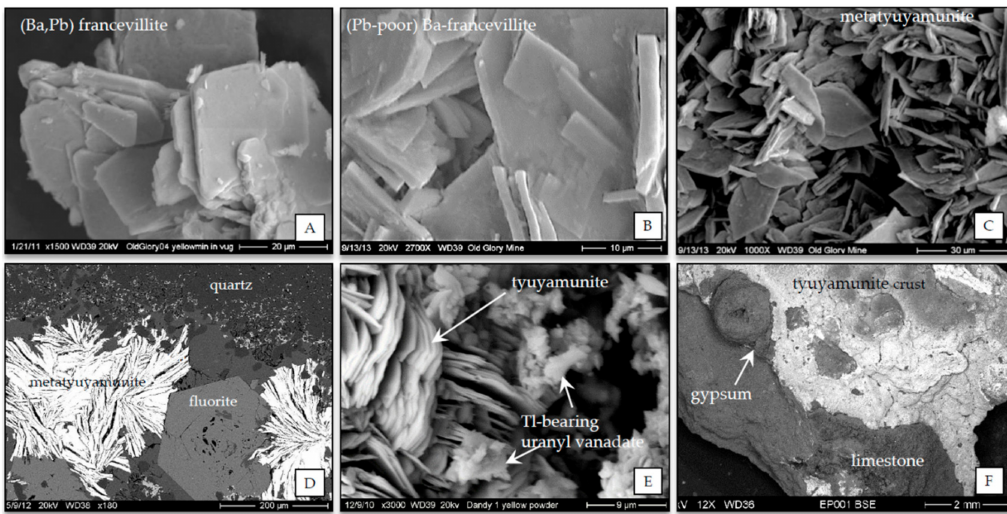
Figure 6. ( A ) (Ba,Pb) francevillite, Old Glory mine, Secondary Electron Imaging (SEI), 1500 × magnification; ( B ) Ba francevillite, Old Glory mine, SEI, 2700 × magnification; ( C ) Metatyuyamunite, Old Glory mine, SEI, 1000 × magnification; ( D ) Metatyuyamunite with fluorite intergrown, with late calcite filling in porosity in a vug of a silicified breccia, Old Glory mine, Backscatter Electron Imaging (BSE), 180 × magnification; ( E ) Tyuyamunite (left) and unidentified Tl-uranyl vanadate mineral, Dandy mine, SEI, 3000 × magnification; ( F ) Cavern type deposit, tyuyamunite coating limestone with secondary gypsum, BSE, E. Pryor